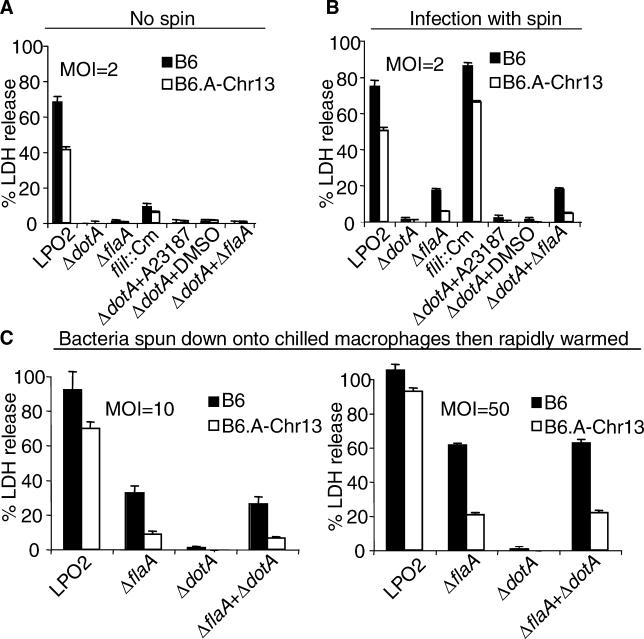
Flagellin-Induced Cytotoxicity of Macrophages Is Independent of Motility but Requires Type IV Secretion(A and B) Centrifugation is required to promote cytotoxicity of a fliI mutant, but does not restore cytotoxicity of a flaA mutant. The calcium ionophore A23187 (1 μM, or a vehicle control, DMSO) was added to some wells simultaneously with the addition of bacteria. Infection and LDH release were assayed as in Figure 3, with or without centrifugation immediately after infection, as indicated.(C) Coinfection of macrophages with a ΔflaA and ΔdotA mutant does not restore cytotoxicity. Infection and LDH release were assayed as in Figure 3, except that higher MOIs were used and chilled macrophages were infected, as indicated.